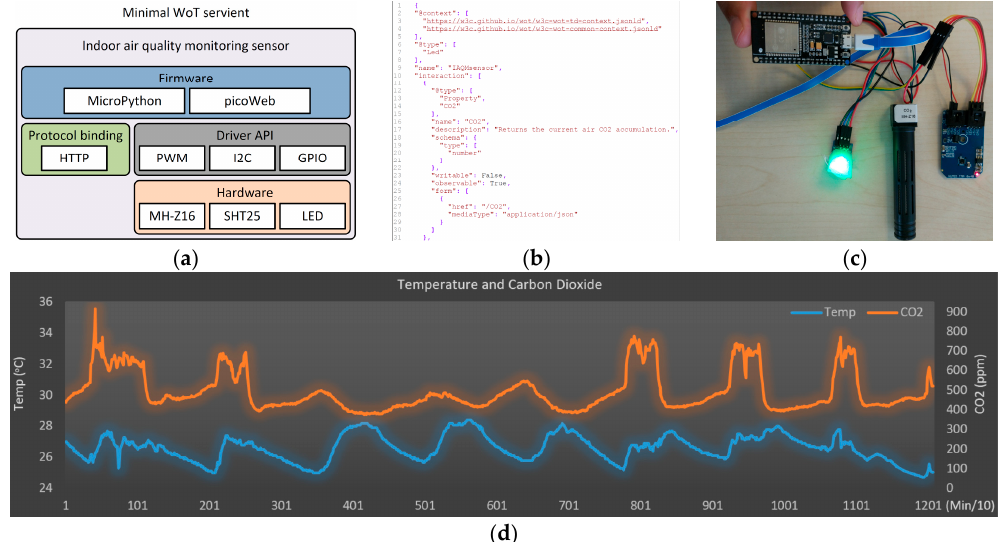
Figure 1. Proposed indoor air quality monitoring sensor: ( a ) Servient architecture of the proposed sensor; ( b ) Thing Description, according to the W3C WoT Architecture (because of space limitations, only the CO 2 section of the file is shown); ( c ) Sensor hardware and wiring; ( d ) Temperature and CO 2 output in an 8-day period (measurements taken every 10